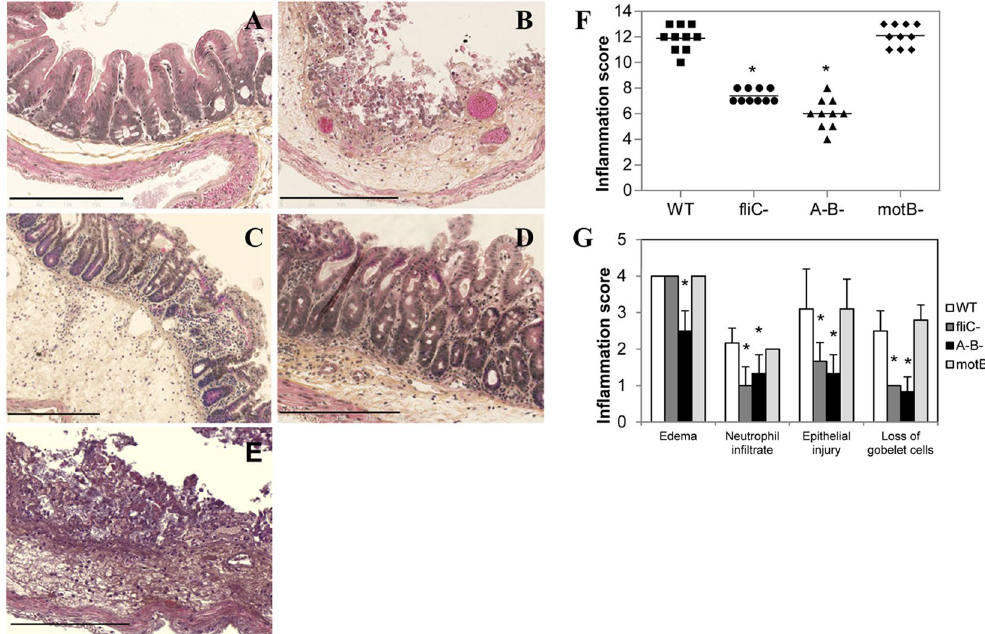
Figure 1. C. difficile R20291 flagella are involved in caecal inflammation of mice. C57BL/6 mice (n = 10) were infected or not and caeca were collected at the clinical end point day 2 for histology. ( A ) Representative histology of caecum of healthy uninfected mice (control) with epithelium integrity; ( B ) R20291 WT-infected mice with ulcerative colitis, necrosis, desquamation, exudates and necrotic cells in the intestinal lumen, edema, inflammatory submucosal cell infiltration, loss of architecture of epithelium and presence of pseudomembranes in caecum; ( C ) R20291 fliC and ( D ) A − B − mutant-infected mice with edema, focal desquamation of necrotic cells in the intestinal lumen and submucosal cell infiltrate; ( E ) R20291 motB mutant-infected mice with similar degree of mucosal lesion than R20291 WT-infected mice (200X magnification). Bar = 200 µ m. ( F ) Inflammation histological scores for individual mice in each group. The horizontal lines represent the mean scores for each group of animals. ( G ) Individual evaluation criteria of intestinal inflammation. The bars represent the mean scores for each group of animals and standard deviations. * P < 0.01 compared to WT-infected